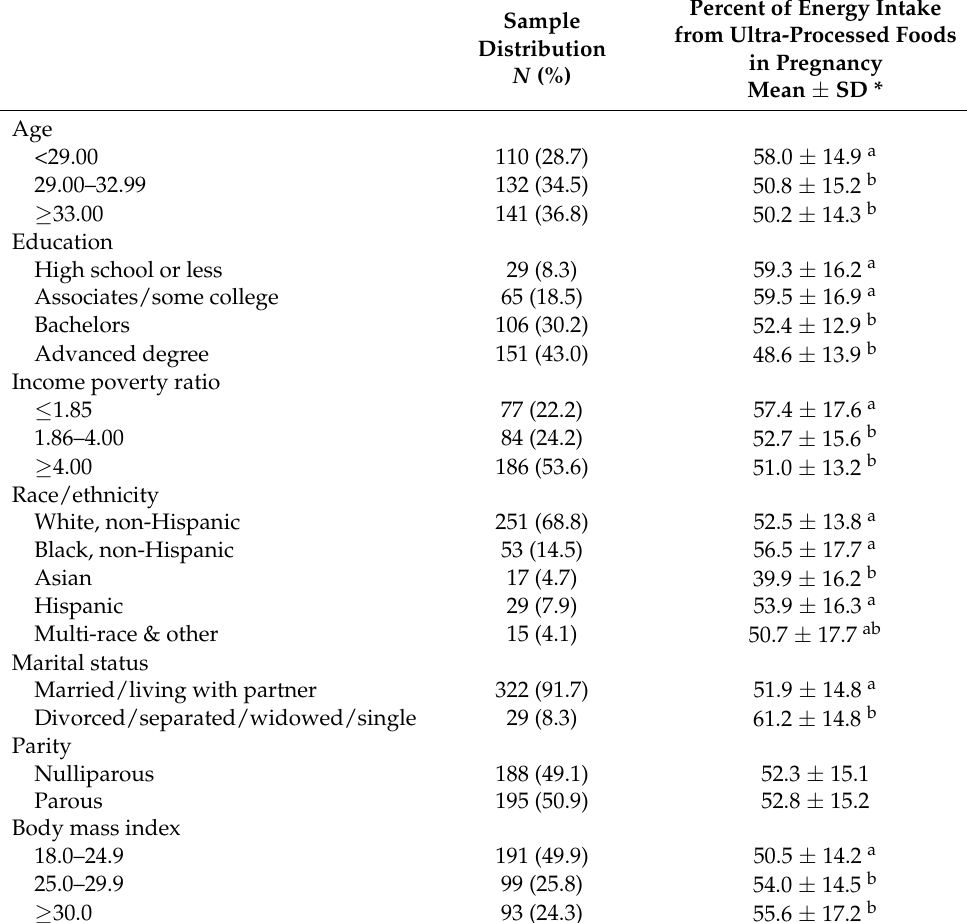
Table 1. Sample characteristics and association with ultra-processed food intake.